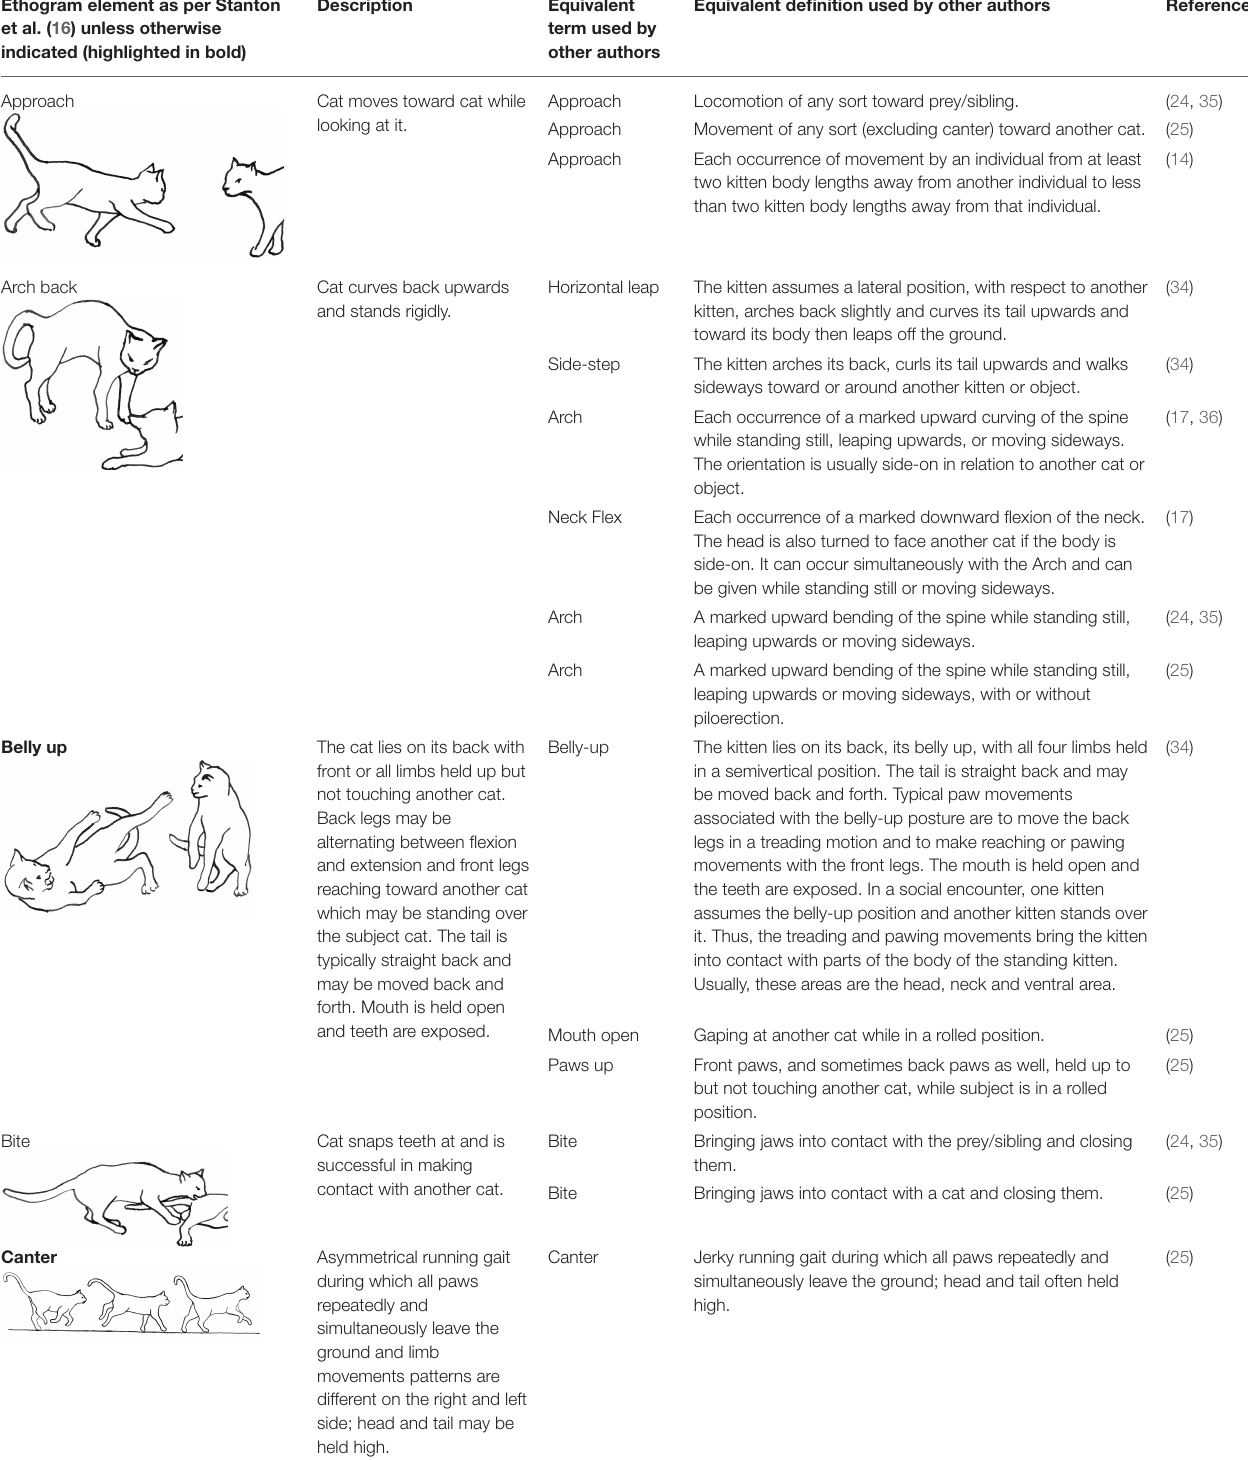
TABLE 1 | Overview ethogram of intercat play behaviours with suggested common terms of the variables. Ethogram element as per Stanton et al. (16) unless otherwise indicated (highlighted in